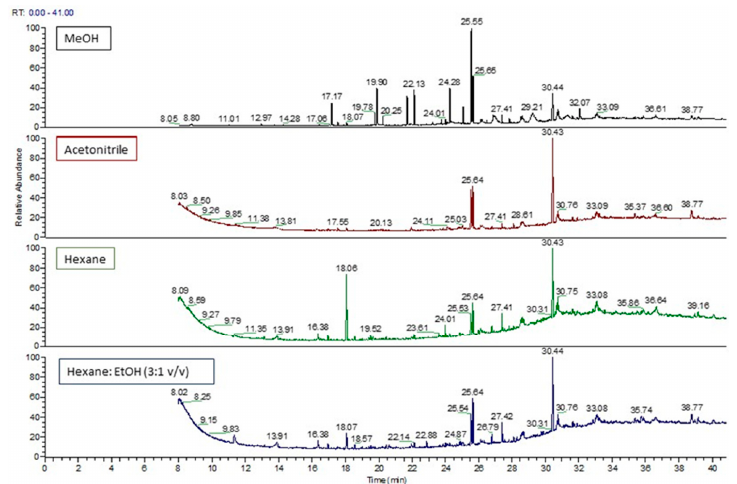
Figure 1. Chromatograms of sample BC04 extracted with different solvents. Table 2. Comparison of the most abundant detected compounds in sample BC04 using different extraction solvents.